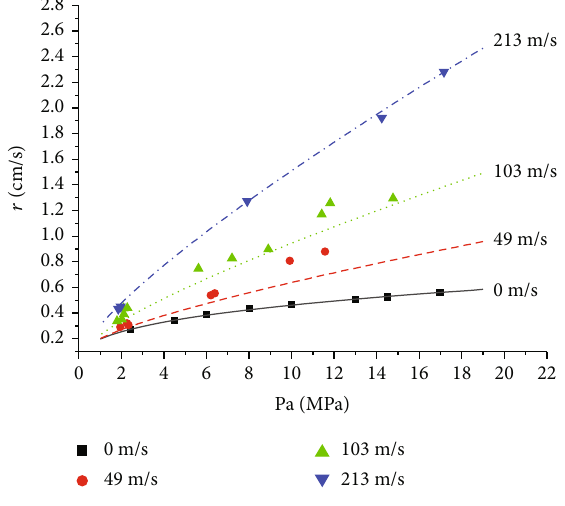
Figure 9: Propellant C. Table 2: Main parameters of cylindrical